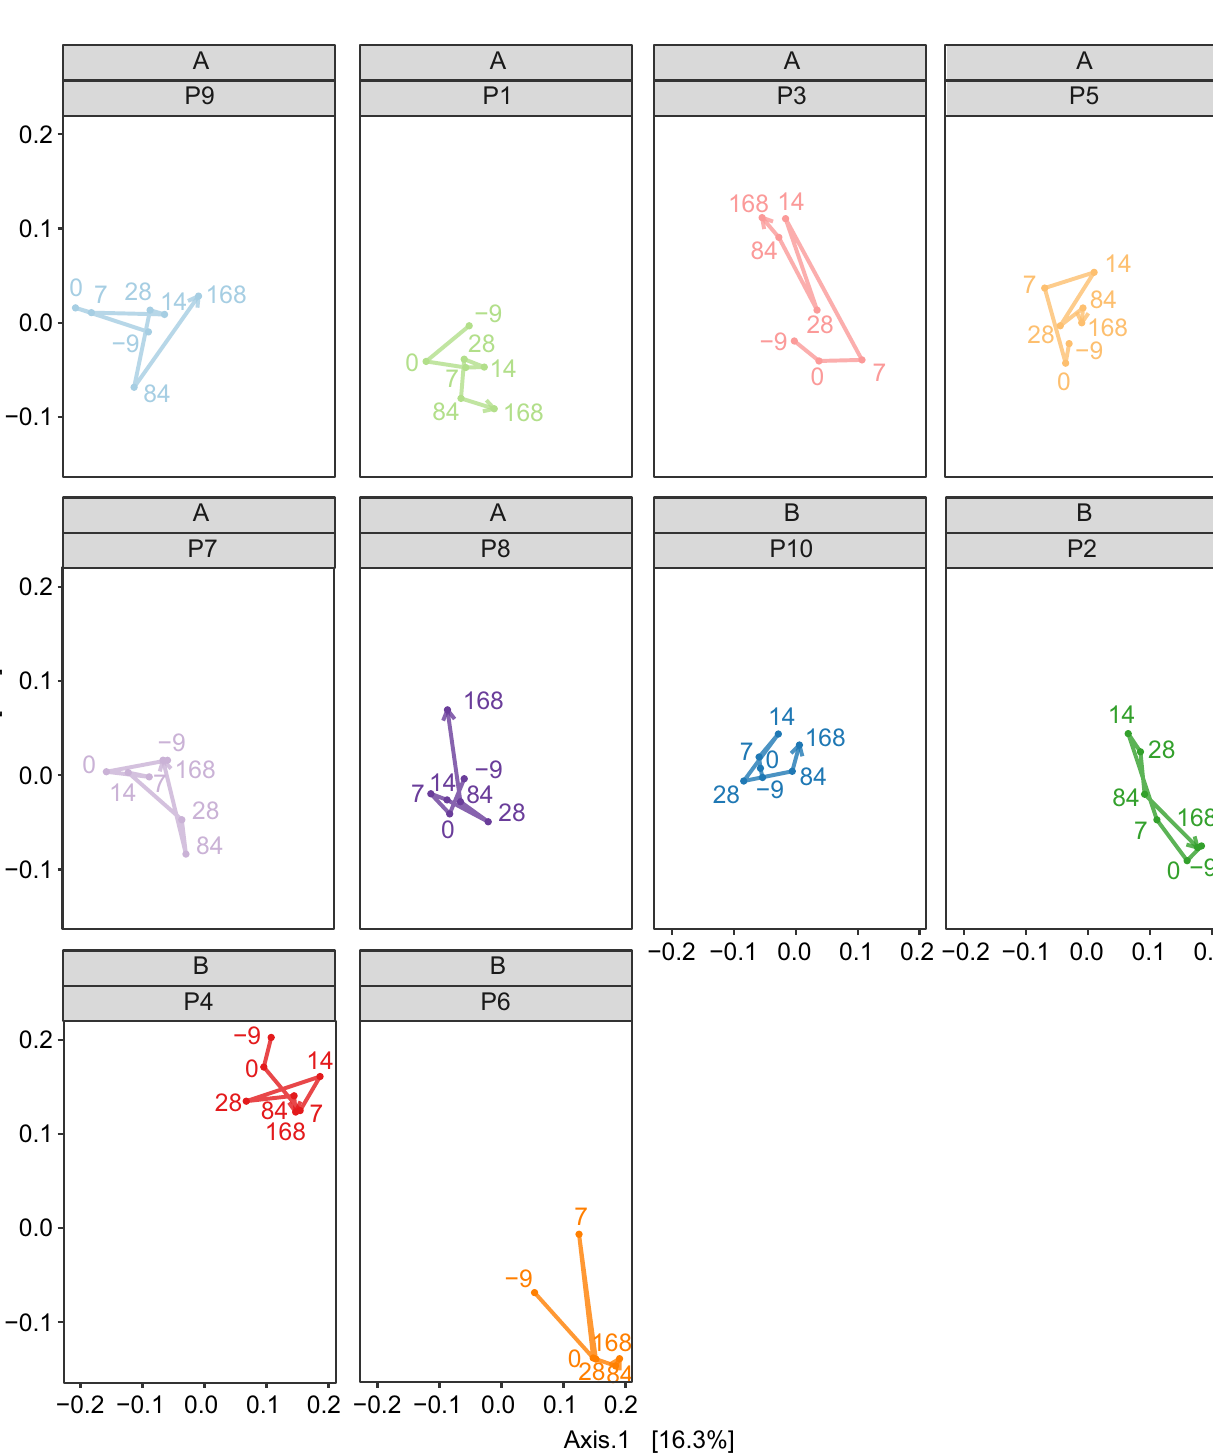
Figure 9. Unweighted UniFrac PCoA of 16S rRNA gene-based prokaryotic community composition of faecal microbiota from individual FFW horses (i.e., P1 to P10). Samples from before (d –9) and after FMT (d 0, d 7, d 14, d 28, d 84 and d 168) are shown (i.e., seven samples for each FFW horse). The time course through the samples is indicated by a line, the direction of which is indicated by the arrowhead. The identity of the donor animal used to prepare the inoculant for each FFW horse is indicated above the FFW horse